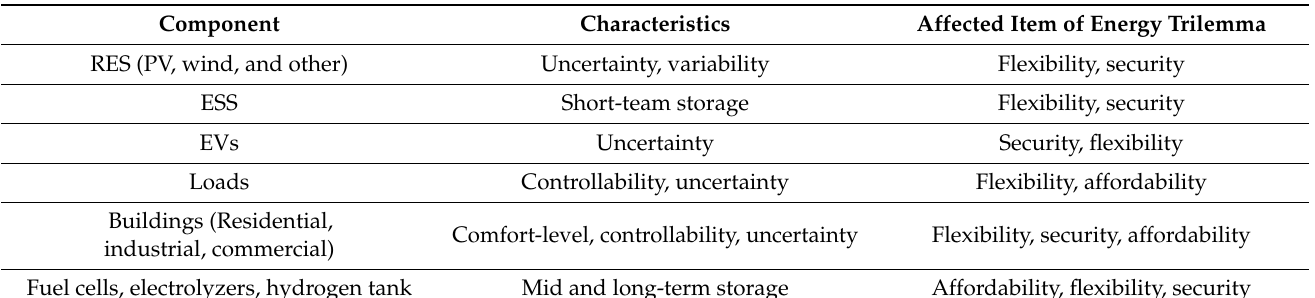
Table 2. Characteristic categorization of MG